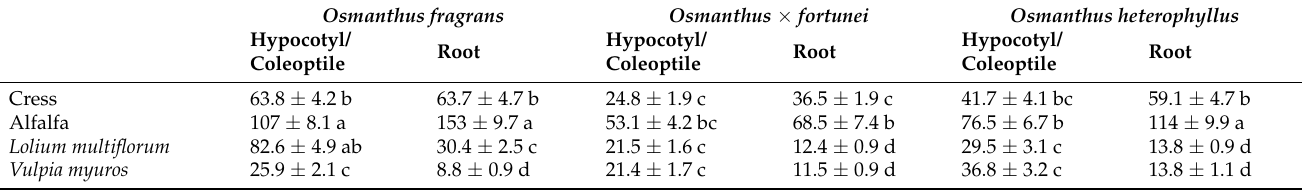
Table 1. IC 50 values (mg leaf equivalent extract per mL) of the extracts of the leaves of O. fragrans , O. × fortunei , and O. heterophyllus on the growth of hypocotyls/coleoptiles and the roots of bioassay plant species. IC 50 values were determined with GraphPad Prism. Different letters in the same column indicate significant differences (Tukey’s HSD test, p ≤